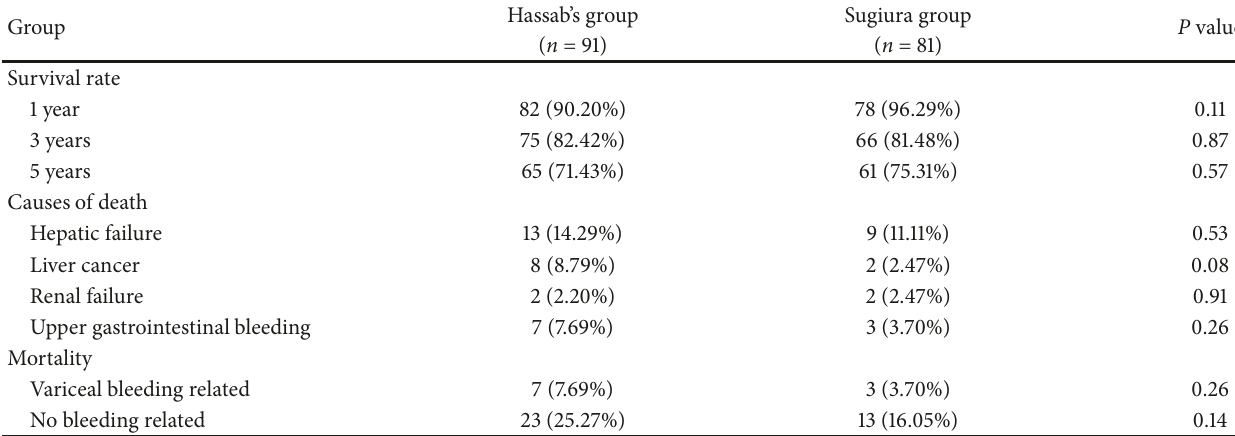
Table 3: Incidence of mortality during